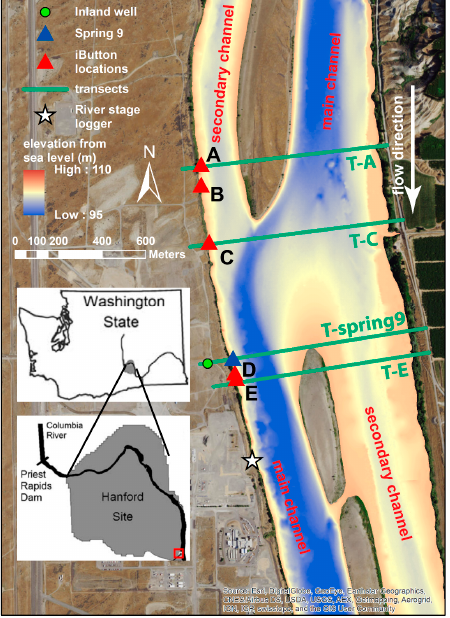
Figure 1. The study river reach. The iButton sites A–E are marked as red triangles. The Spring 9 location is marked as a blue triangle. location is marked as a blue